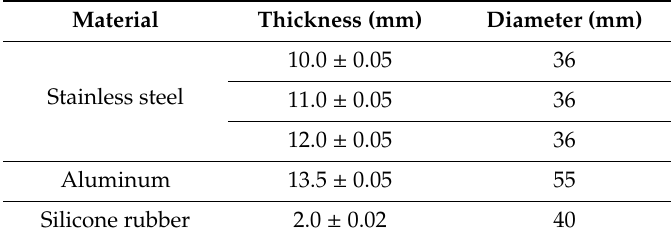
Table 1. Circular plates used for the study: materials and thicknesses.